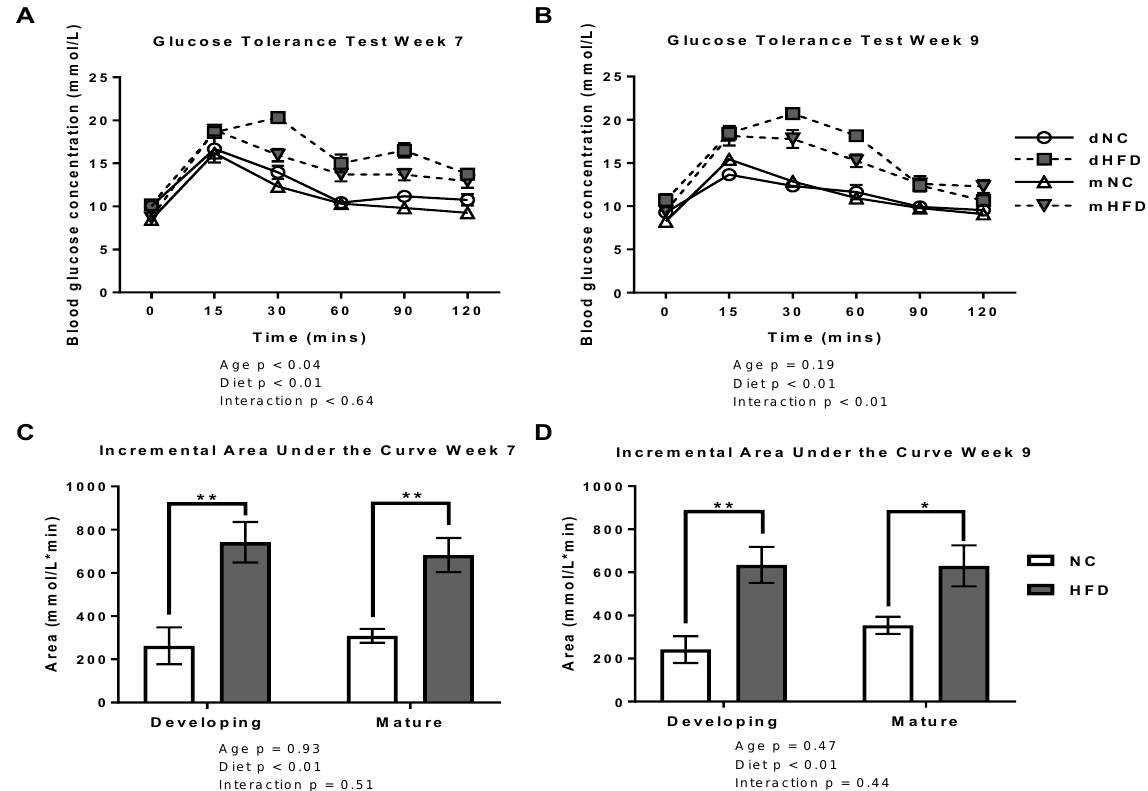
Figure 2. The high fat diet decreased glucose tolerance in both developing and mature mice. ( A , B ) Oral glucose tolerance test response curved during week 7 and 9 on diets for developing normal chow (dNC), developing high fat diet (dHFD), mature normal chow (mNC) and mature high fat diet (mHFD) groups. Mice received a 2 g/kg body weight dose of glucose